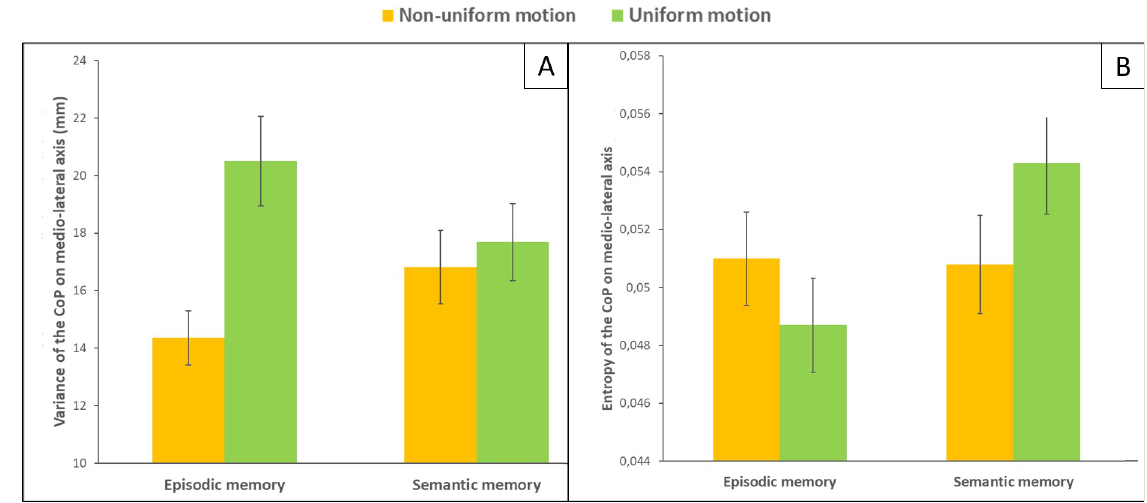
Fig 3. Effect of visual motion on posture during long-term memory tasks. (A) Variance of the CoP on medio-lateral axis during episodic and semantic memory task for both visual stimulation uniform and non-uniform motions. Bars represent the standard error. (B) Entropy on medio-lateral axis during episodic and semantic memory task for both visual stimulation uniform and non-uniform motions. Bars represent the standard error.